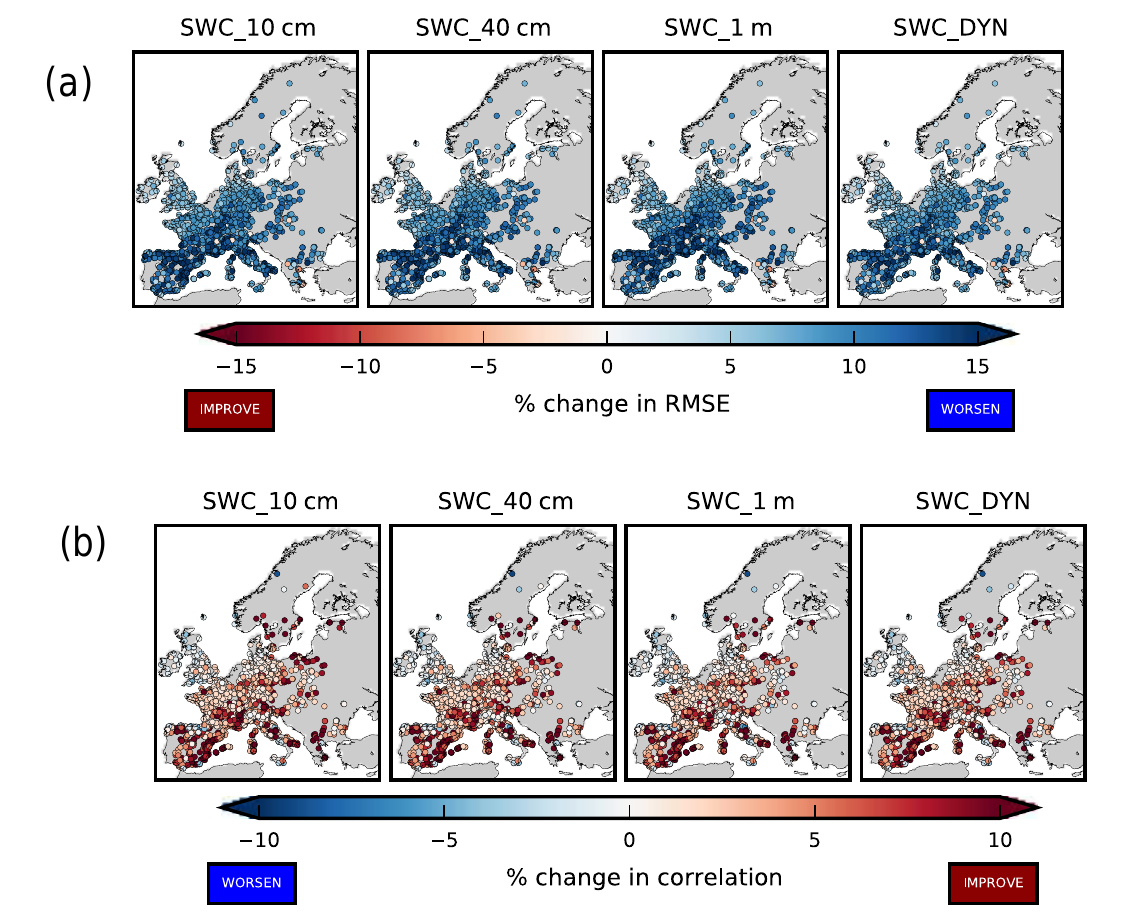
Figure 6. Percentage change in RMSE (a) and correlation coefficient (b) computed using hourly data in the time period April–September. The reference simulation is